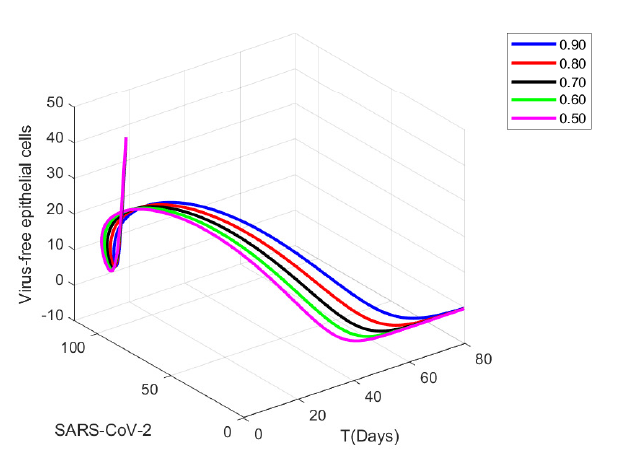
Figure 8. Graphical representation of the SARS-CoV-2 and virus-free epithelial cells for fractional order α = 0.9, 0.8, 0.7, 0.6, 0.5 when R 0 < 1.